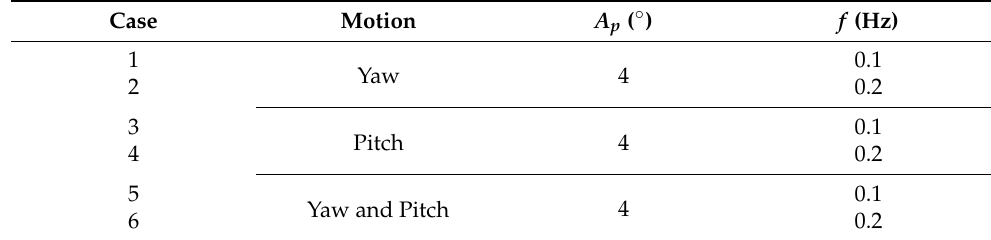
Table 2. Surge and pitch motion